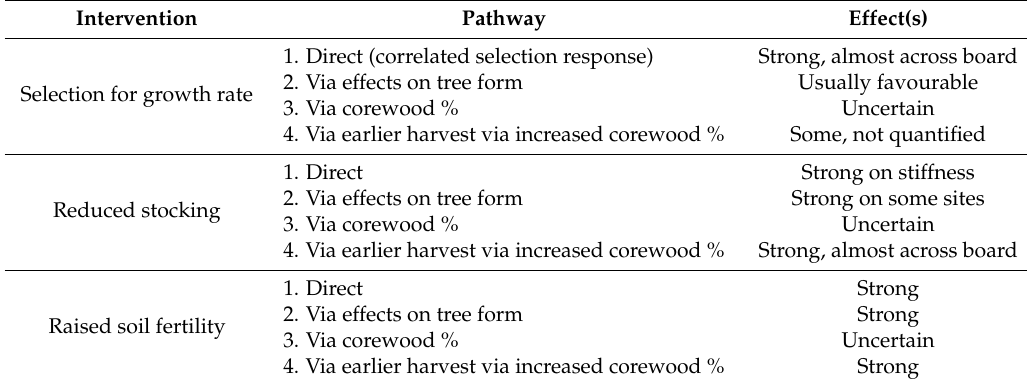
Table 5. Putative importance in adverse effects of main interventions on wood of alternative pathways of influence for radiata